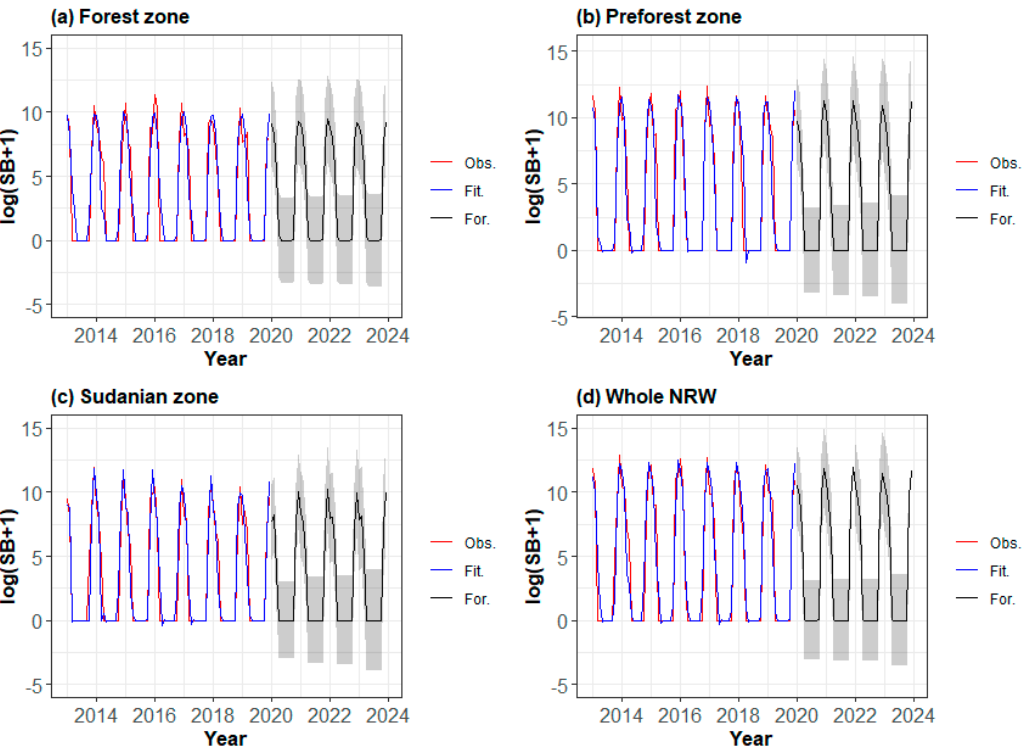
Figure 8. Forecasts from the SARIMA models applied to burnt areas in the ( a ) forest zone, ( b ) pre-forest zone, ( c ) Sudanian zone, and ( d ) whole NRW.